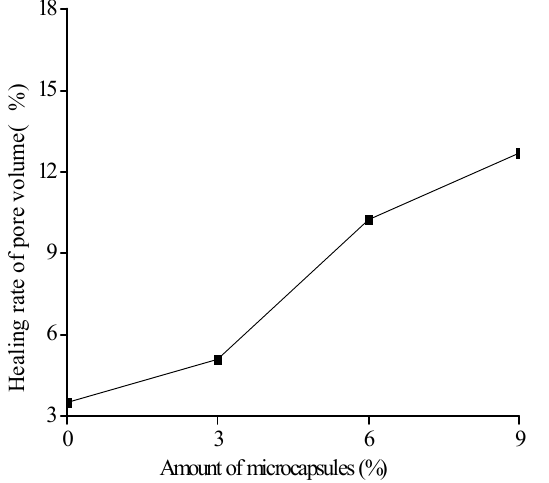
Figure 18. Healing rate (Equation (7): η P ) of porosity with amount of microcapsules.